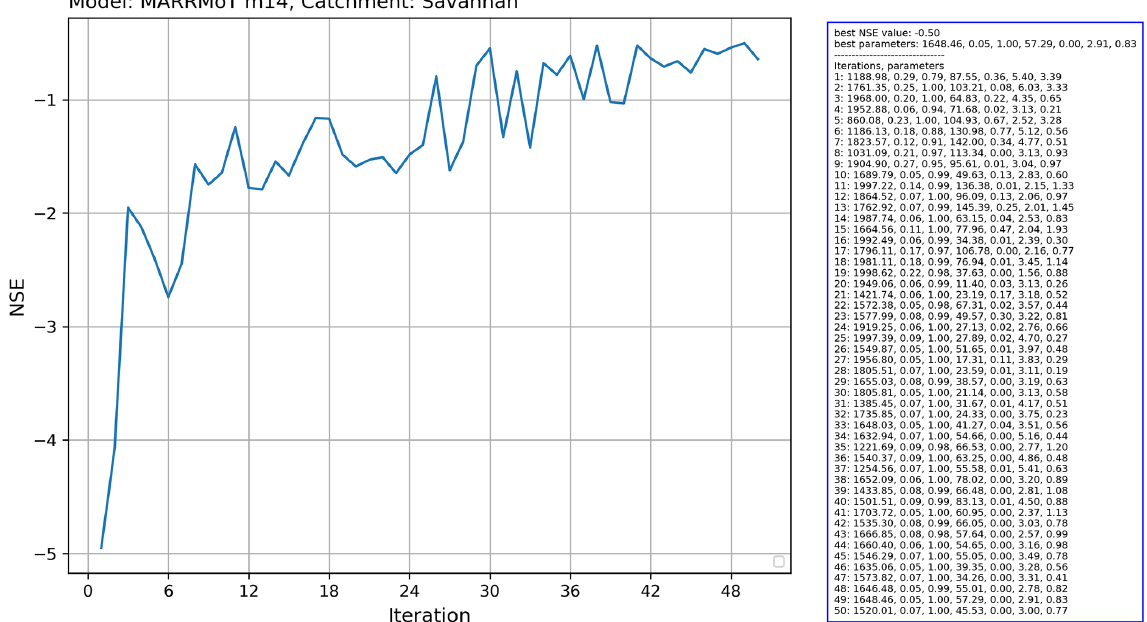
Figure 15. Output of the running the Covariance Matrix Adaptation Evolution Strategy (CMA-ES) calibration scheme from the CMA- ES/pycma software package on the MARRMoT m14 model (an implementation of TOPMODEL) for the Savannah